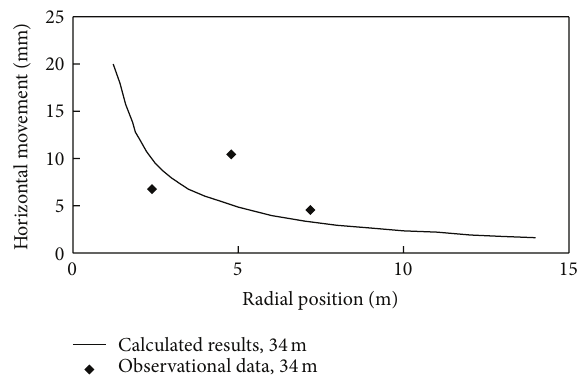
Figure 5: Observational data and calculated results of horizontal